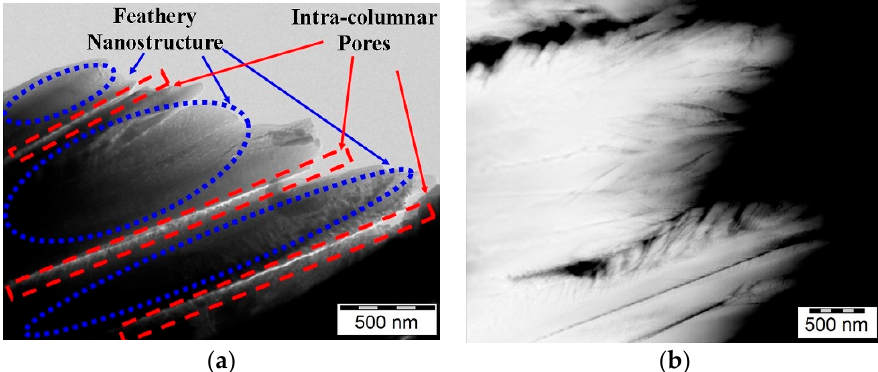
Figure 3. Microstructure of Ce 2 Zr 2 O 7 stabilized La 2 Zr 2 O 7 coatings [39]: ( a ) Transmission electron microscopy image; ( b ) High angle annular dark fields image.